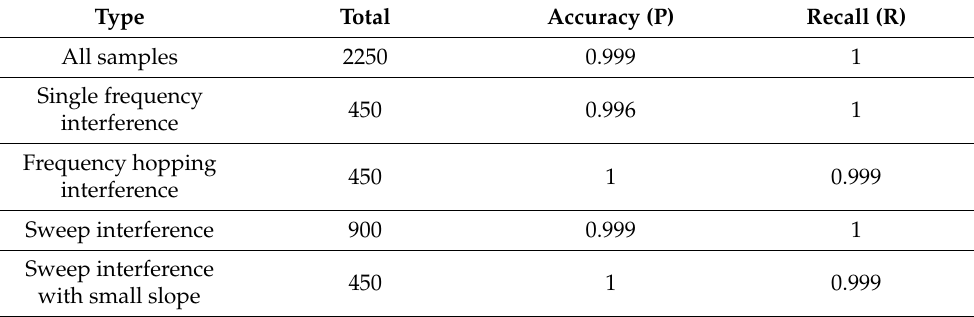
Figure 9. Confusion matrix of interference pattern classification results. Table 1. Quantitative record of interference pattern test results.